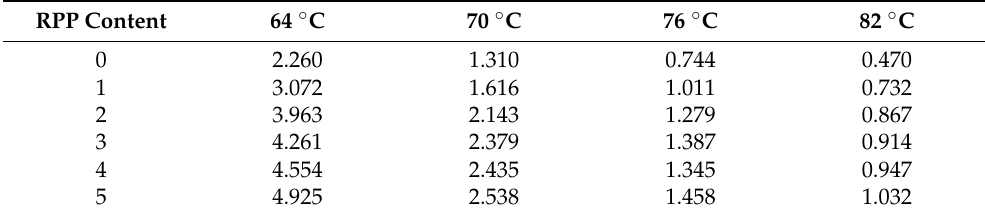
Figure 11. Influence of temperature and RPP content on the G*/sin δ of modified asphalt. Table 4. Influence of temperature and RPP content on G* (kPa) of modified asphalt.